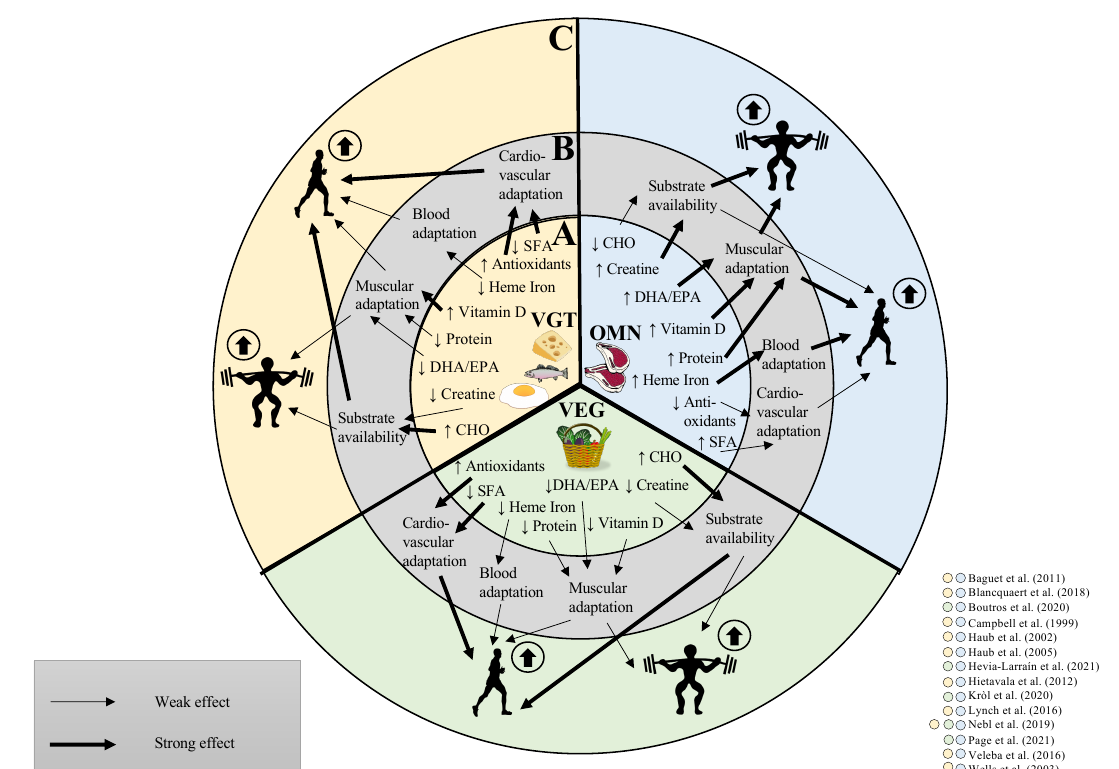
Figure 1. Impact of dietary properties on physiological subsystems and performance. ( A ): Vegan, vegetarian and omnivorous diets possess unique nutritional properties. This affects the intake of differential levels of polyunsaturated fatty acids (DHA/EPA), carbohydrates (CHO), creatine, protein, vitamin D, heme iron, antioxidants and saturated fatty acids